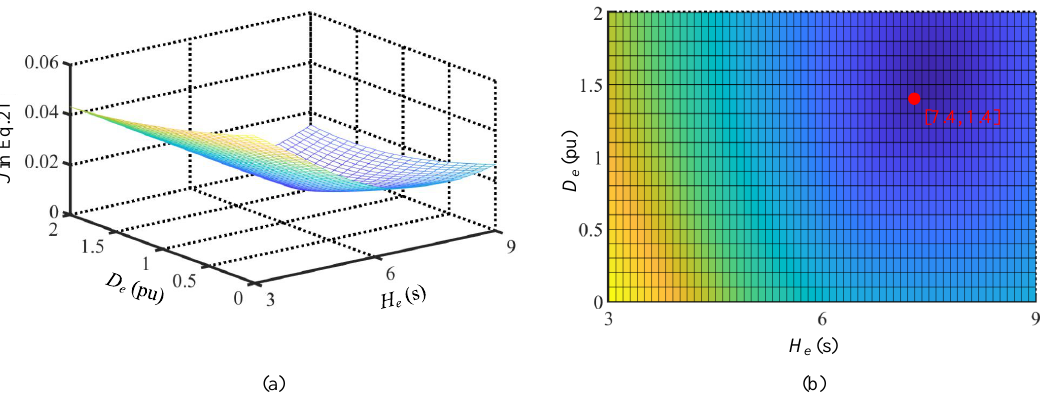
Figure 15. Dynamics of J in Equation (21) with different H e and D e . ( a ) 3-D graph, ( b ) 2-D filling graph.